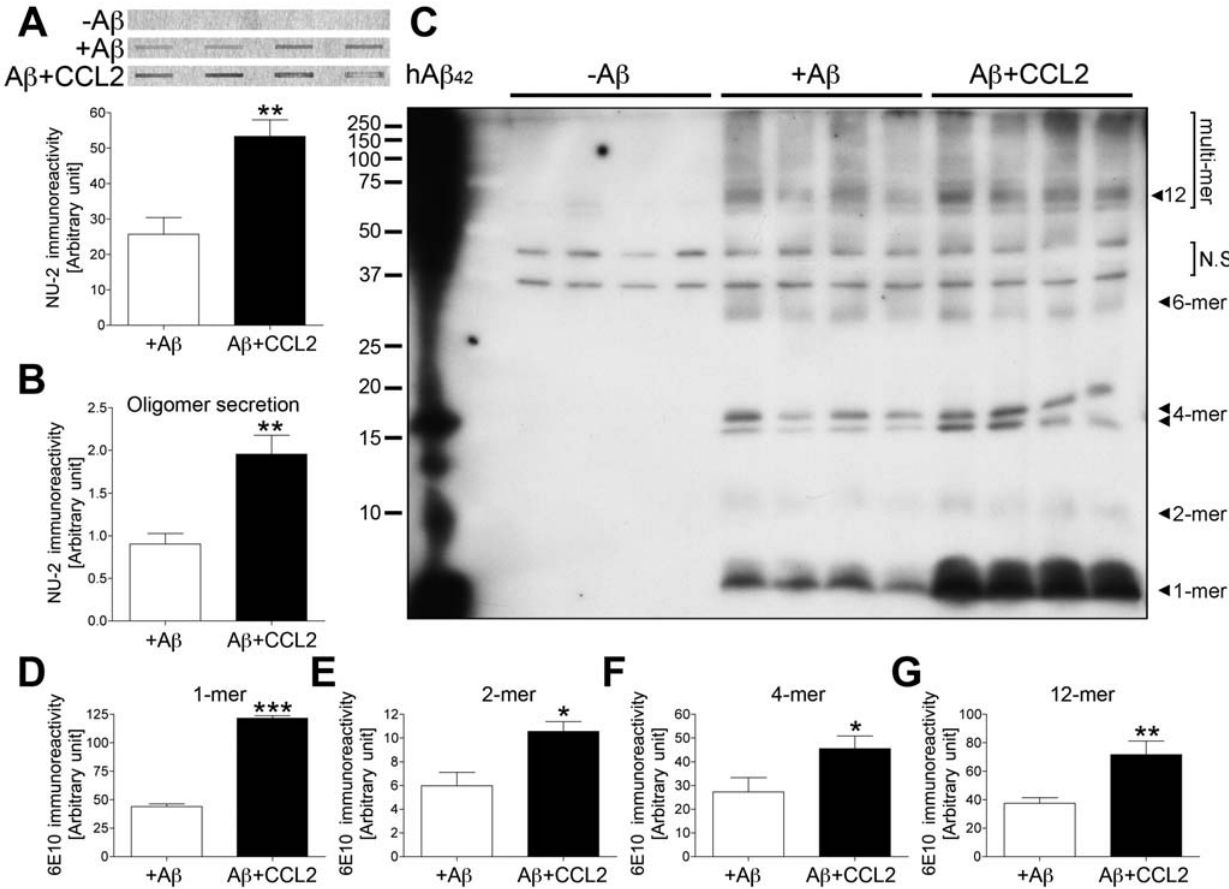
Figure 7. CCL2 accelerates intracellular A b microglial oligomer formation. (A, B) Quantification of A b oligomers in mouse microglia (A), or secreted from mouse microglia (B), incubated without A b (-A b ), with A b ( + A b ), and co-incubated with CCL2 (10 ng/ml, A b + CCL2) for 1 h, assessed by dot blot. Band luminescent intensities were quantified by Typhoon Phosphoimager. ** denotes p , 0.01 as determined by Student’s t -test. (C) Identification of A b oligomers in mouse microglia assessed by Western blot. Synthetic human A b 1–42 peptide (hA b 42) was used as a size marker and positive control (left lane). Arrows indicate respective migration positions of monomers (1-mer), dimers (2-mer), tetramers (4-mer), hexamers (6-mer) and dodecamers (12-mer). Band luminescent intensities for monomers (D), dimers (E), tetramers (F), and dodecamers (G) were quantified by Image J software. *, **, or *** denotes p , 0.05, 0.01, or 0.001 as determined by Student’s t -test, respectively.